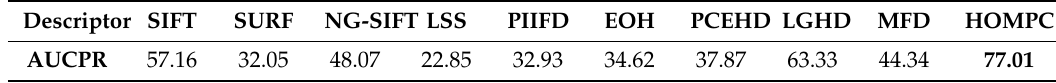
Figure 21. The correctly matched (green lines) and falsely matched (red lines) results for SURF ( a ), LGHD ( b ), and our HOMPC ( c ) descriptors. The displayed green and red lines are used to visually compare the descriptor performance. The greater number of the green lines, the better. The higher the ratio of the green lines, the better. The quantitative results are also listed below each pair of images. Table 7. AUCPR (%) results for all the descriptors.